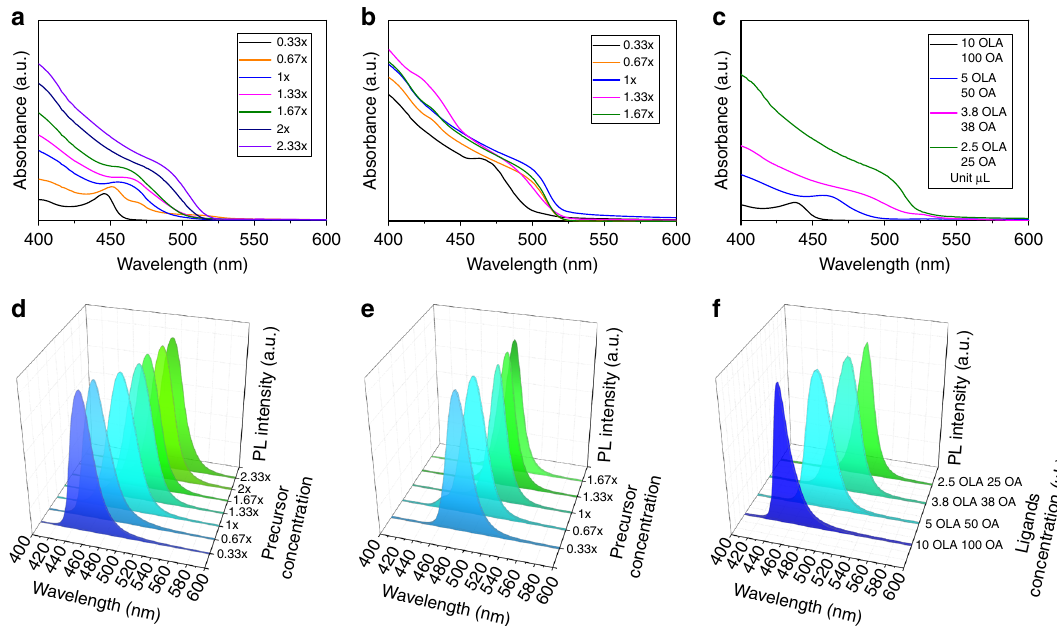
Fig. 1 Optical absorption and photoluminescence spectra of the samples. Optical absorption ( a , b , c ) and photoluminescence (PL) spectra ( d , e , f ) of CH 3 NH 3 PbBr 3 NCs. Samples were synthesized at room temperature (RT) ( a , d ) and at 60 o C ( b , e ) with a varying amount of precursors and a fi xed